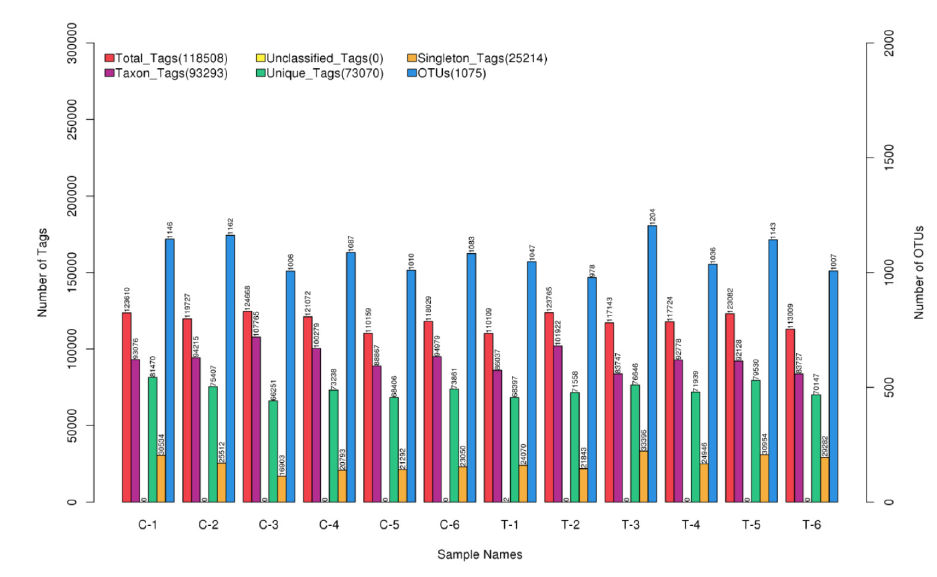
Figure 1. Statistics of the number of OTUs and Tags of different samples.